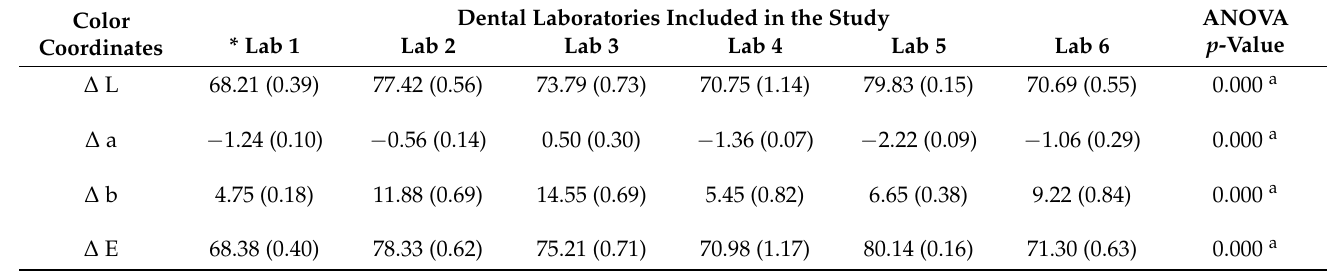
Table 2. Mean values, standard deviations, and ANOVA results of the color coordinates for shade B1.